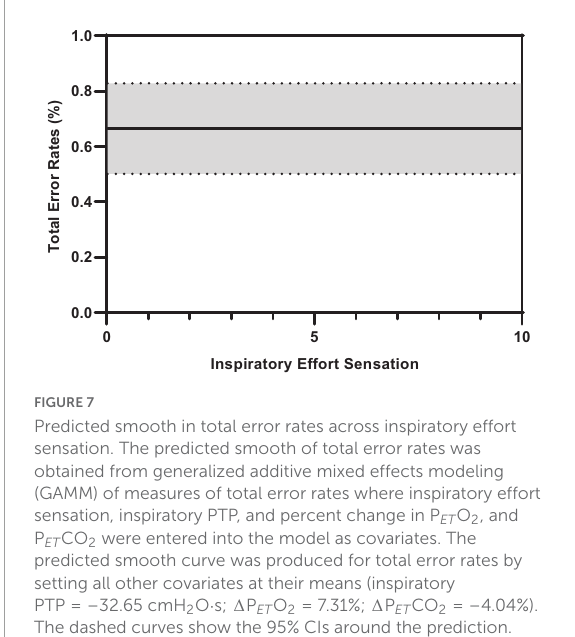
FIGURE8 Predicted smooth in total error rates for percent change P ET O 2 from baseline. The predicted smooth of total error rates was obtained from generalized additive mixed effects modeling (GAMM) of measures of total error rates where inspiratory effort sensation, inspiratory PTP, and percent change in P ET O 2 , and P ET CO 2 were entered into the model as covariates. The predicted smooth curve was produced for total error rates by setting all other covariates at their means (inspiratory effort sensation = 3.89; inspiratory PTP = –32.65 cmH 2 O · s; (cid:49) P ET CO 2 = –4.04%). The dashed curves show the 95% CIs around the